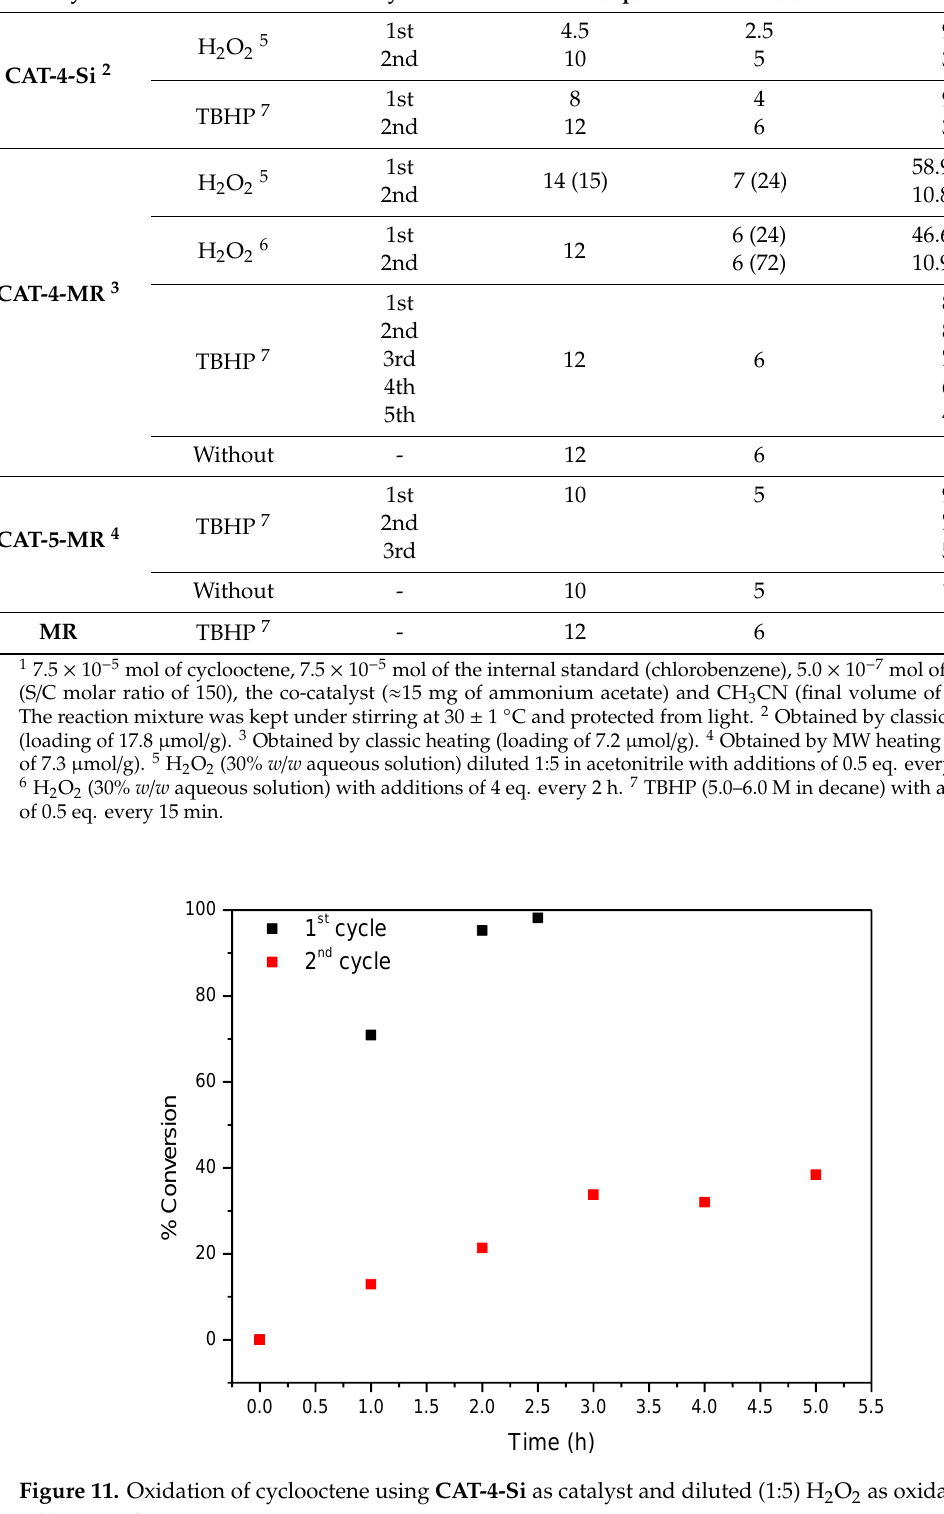
Figure 11. Oxidation of cyclooctene using CAT-4-Si as catalyst and diluted (1:5) H 2 O 2 as oxidant with additions of 0.5 eq. every 15 min.